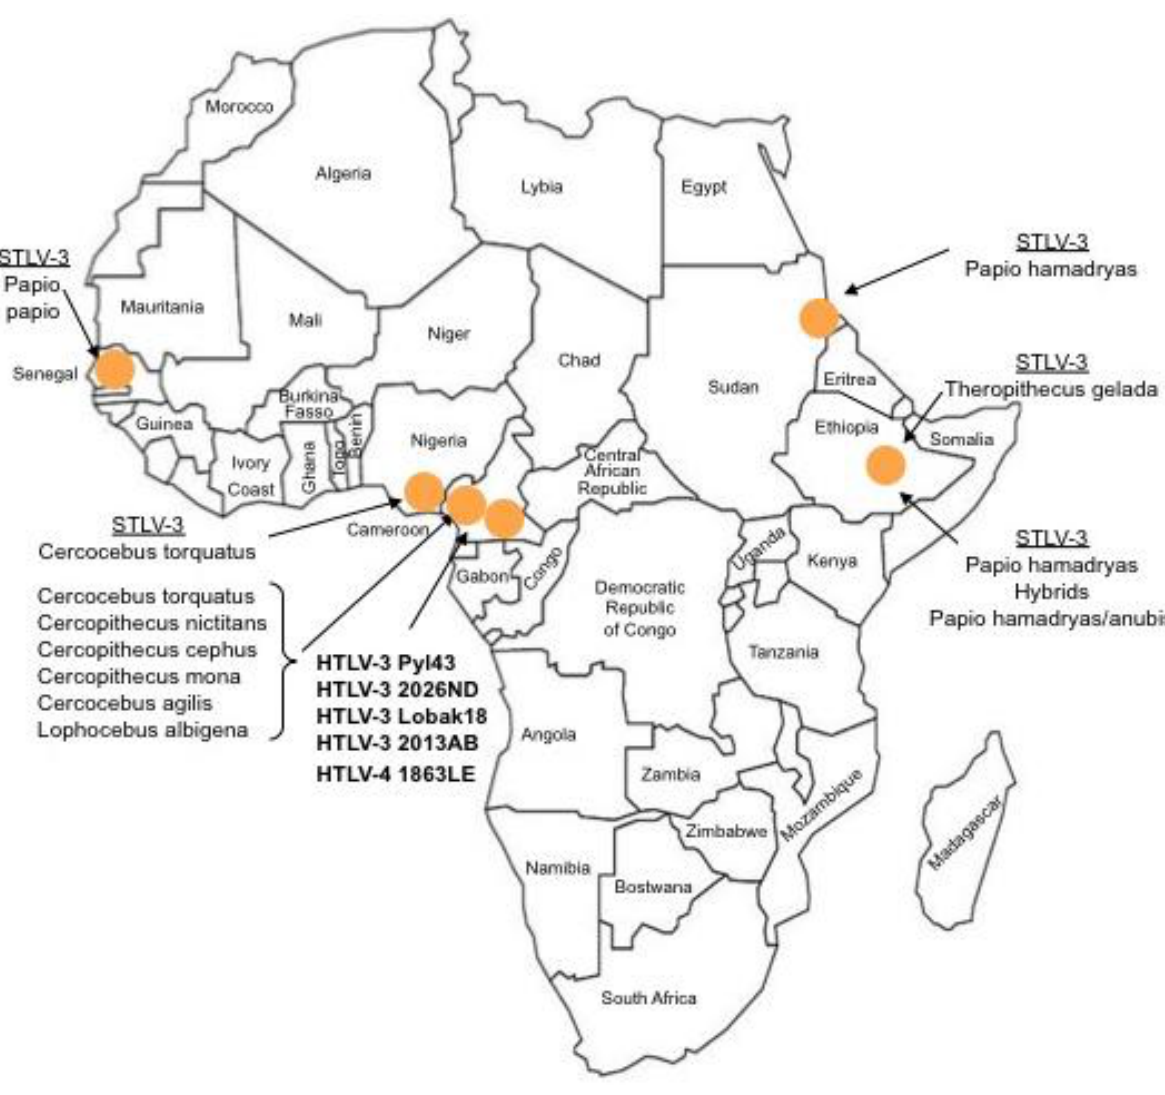
Figure 1. Current known geographical distribution of STLV-3, HTLV-3 and HTLV-4 viruses in the African continent. HTLV-3 and HTLV-4 are designated in